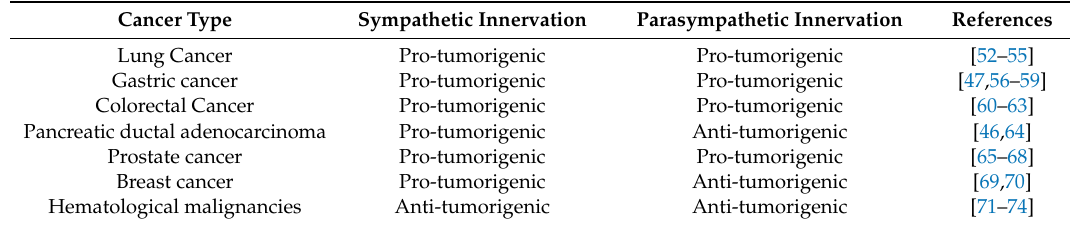
Table 2. The relationship between cancer type and the e ff ect of sympathetic and parasympathetic innervation. Cancer